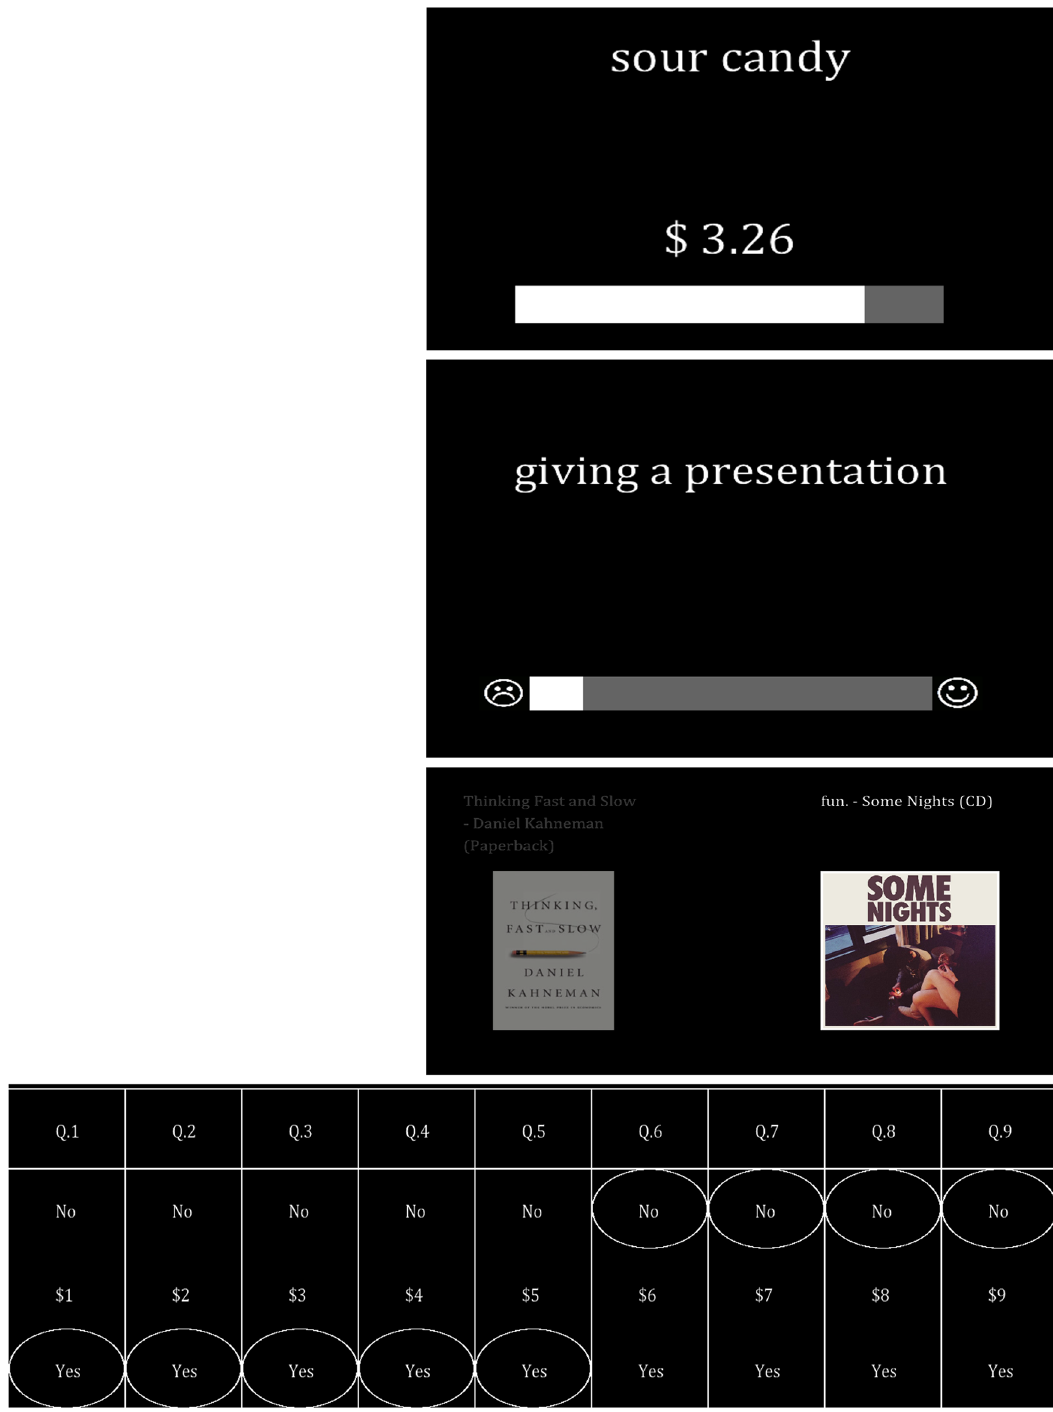
Fig 2. Example screens of behavioral value-elicitation procedures. From top to bottom: auction bidding with snack foods, visual analog scale with daily activities, choices between consumer goods, and payment card response screen for environmental proposals.